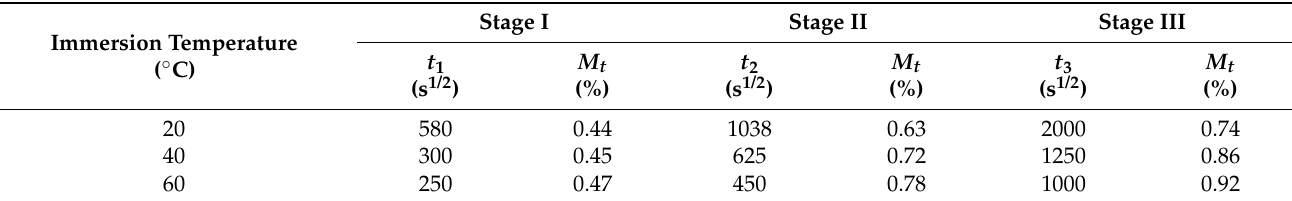
Table 1. Water absorption characteristics of epoxy resin immersed in distilled water at different temperatures. Immersion